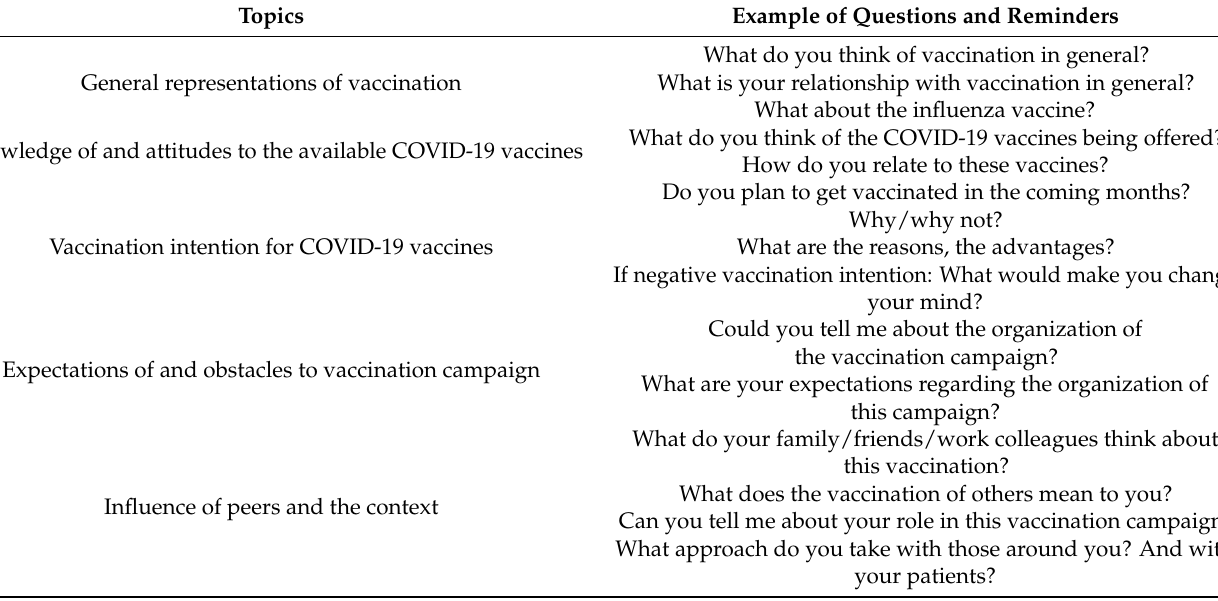
Table 1. Semi-structured interview guide for health professionals at the University Hospital of Bordeaux, France, from January to April